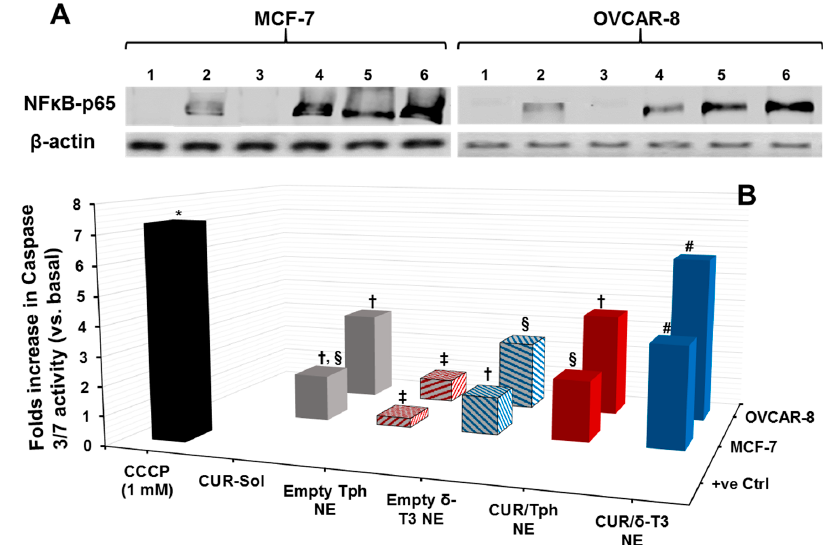
Figure 5. Evaluation of NF- κ B pathway inhibition and apoptosis induction. Both test cancer cell models, MCF-7 and OVCAR-8, were treated with various preparations at 25 μ M of CUR-equivalent concentration, and assayed utilizing ( A ) western blot analysis of inhibition of cytosolic NF- κ B, following treatment with different samples. For each treated cancer cell line, lanes 1, 2, 3, 4, 5, and 6 represent untreated control, CUR-Sol, empty Tph NE, empty δ -T3 NE, CUR/Tph NE, CUR/ δ -T3 NE, respectively. A total of 30 and 20 μ g of protein extracts were loaded per well for MCF-7 and OVCAR-8 cells, respectively, and β -actin served as a loading control ( n = 3); and ( B ) microplate-based fluorimetric